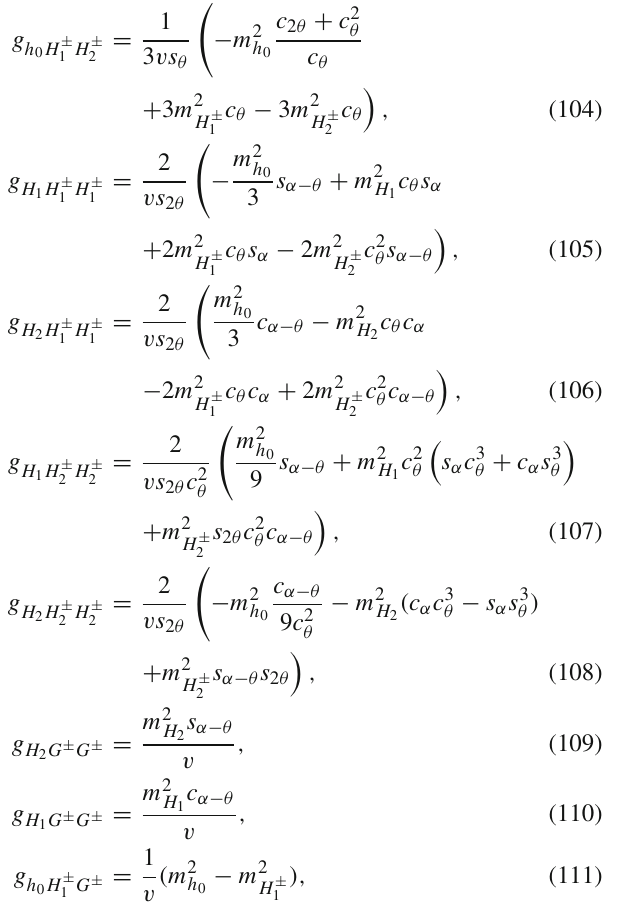
Table 2 Parameter values in scenario A that make the one-loop mixing parameter φ = 0, taking into vanish, (cid:18) H 1 H 2 account only the scalar and gauge contributions